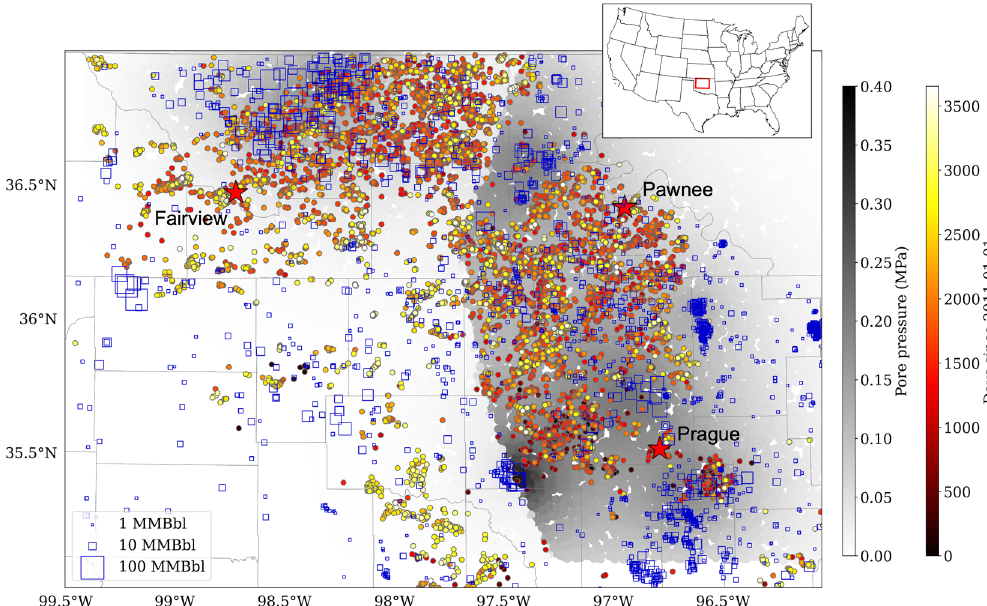
Figure 1. Map view of the declustered seismicity and well injections. Squares: injection wells scaled by the cumulative injection volume from 2011 to 2019. Circles: M ≥ 2.2 earthquakes from 2011 to 2020, colored by their origin times. The gray lines are county boundaries in Oklahoma. The background shows the modeled pore pressure in June, 2015 5 . The three red stars show the location of M > 5 earthquakes in Fairview, Pawnee, and Prague in Oklahoma. The inset figure shows the location of our study area (the map is created in Python (Version 3.6); software available at https:// www. python.